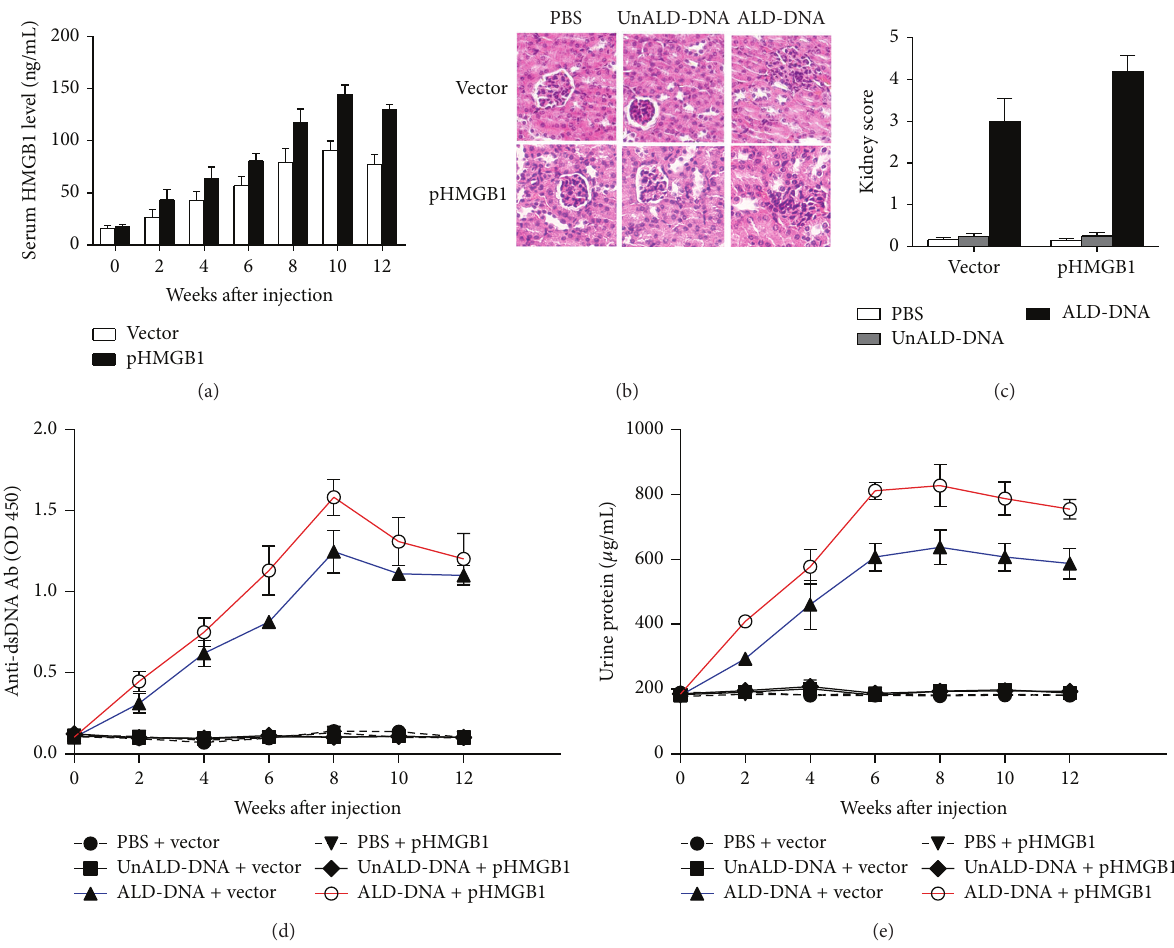
Figure 2: HMGB1 overexpression could promote the severity of SLE. BALB/c mice were administrated intramuscularly with 100 𝜇 g pHMGB1 or empty-vector per mouse. 72 h following injection, mice were then injected subcutaneously with ALD-DNA (50 𝜇 g/mouse) for total 3 times in4weeks.(a)ThedynamicsofserumHMGB1levelsweredeterminedbyELISAevery2weeksafterinitialinjection.Dataaremeans ± SDfrom 8 mice in each group. (b) Nephritic pathology was evaluated by H&E staining of renal tissues. Images (magnification × 200) are representative of at least 8 mice in each group. (c) The kidney score was assessed using paraffin sections stained with H&E in (b). ( 𝑛 = 8 ). (d) Serum anti- dsDNA antibody levels were measured by ELISA every 2 weeks after initial injection. Data are means ± SD from 8 mice in each group. (e) Urine protein levels of the mice were assessed by BCA method every 2 weeks. Data are means ± SD from 8 mice in each group. ∗ 𝑃 < 0.05 .